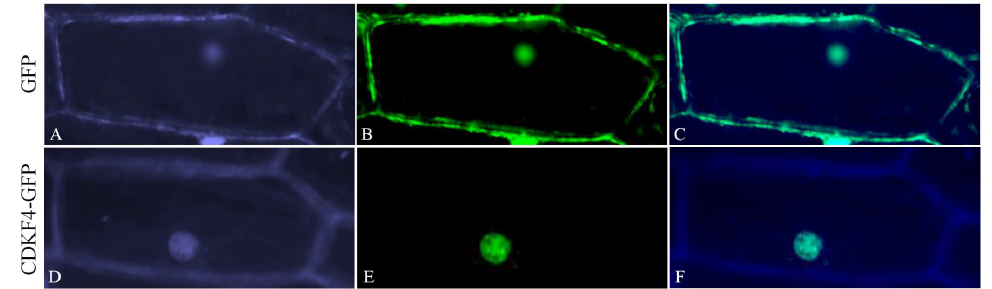
Figure 7. Localization of Gh_D12G2017 (CDKF4) in onion epidermal cells. ( A – C ) Onion epidermal cells transformed with 35S::GFP. ( D – F ) Onion epidermal cells transformed with 35S: Gh_D12G2017_ GFP ( A , D ) Light field with magnification of X400 to display morphology. ( B , E ) Dark field images for the detection of green fluorescent protein (GFP) fluorescence. ( C , F ) Superimposed light and dark field